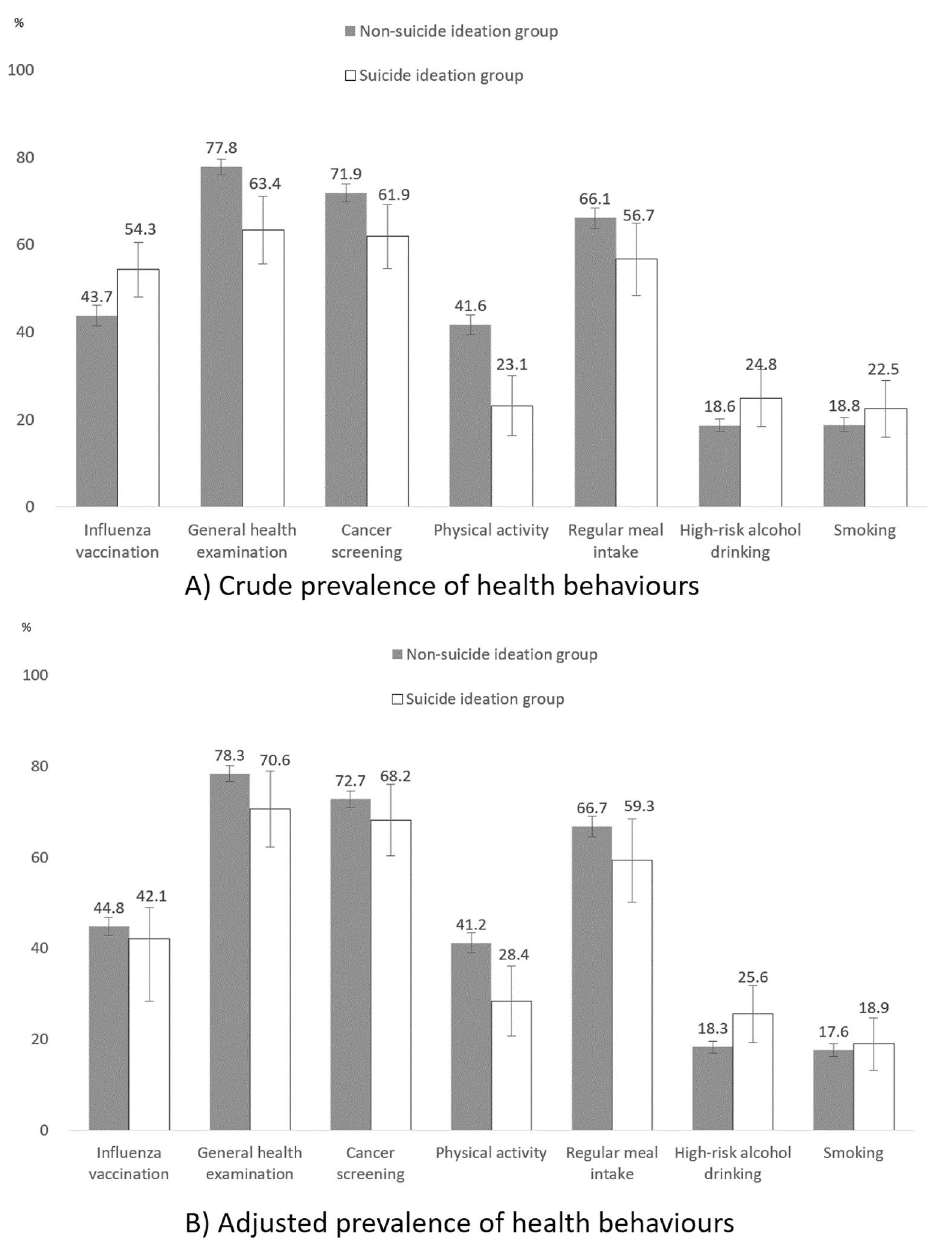
Figure 1. Crude and adjusted prevalence of preventive health behaviors among suicide ideation and non- suicide ideation